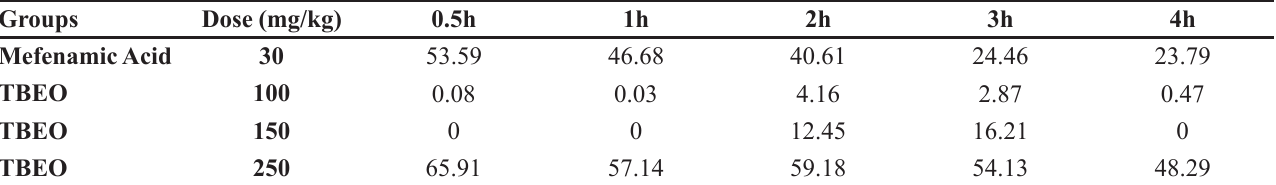
TABLE I - Effect of TBEO on the carrageenan induced inflammation Groups